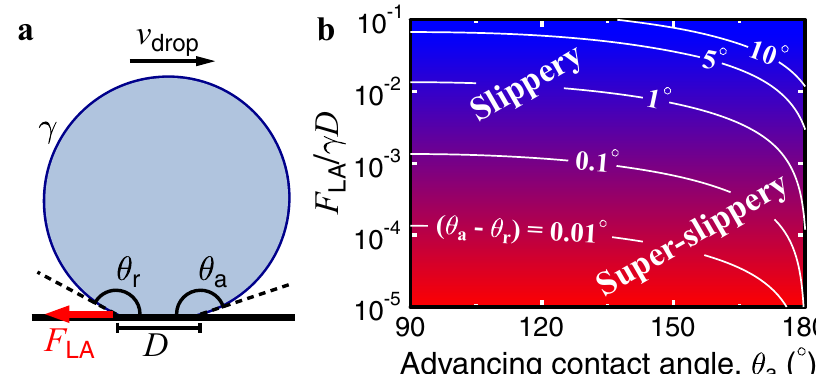
Fig. 1 Friction force of droplets on slippery surfaces. a Schematic drawing of a droplet (surface tension γ ) moving on a superhydrophobic surface with a constant speed v . The motion is opposed by the friction force F , which is a function of the contact region diameter ( D ) and the advancing and receding drop LA contact angles ( θ a ¼ 166 (cid:2) and θ r ¼ 156 (cid:2) in this example). b The dimensionless theoretical friction force calculated using Eq. (1) plotted as a function of (cid:3) θ advancing contact angle for different contact angle hysteresis ( θ ) values. On super-slippery surfaces, the contact angle hysteresis decreases to a r unmeasurably low values around F LA = γ D ≲ 10 (cid:3) 3